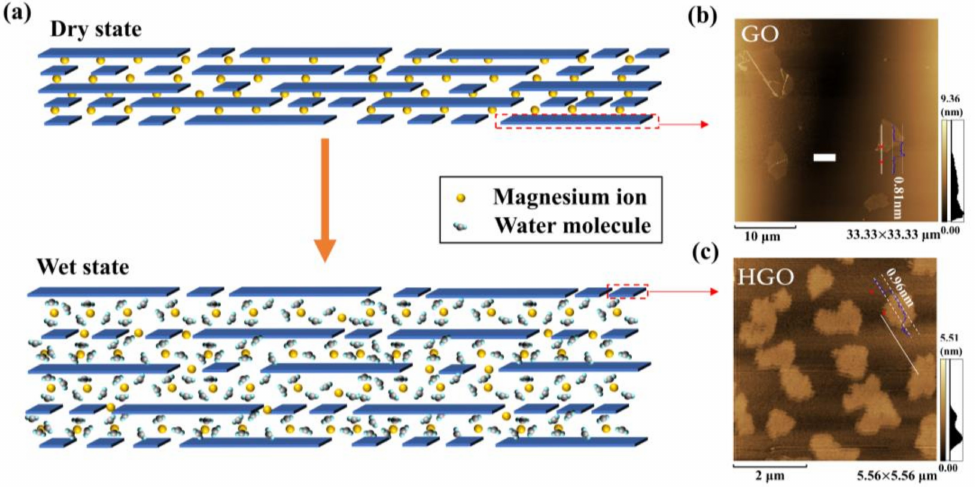
Figure 2. ( a ) Schematic diagram of HGO adsorption/desorption of water molecules. ( b , c ) Atomic Force Microscopy (AFM) images of single flakes of Graphene Oxide (GO) and